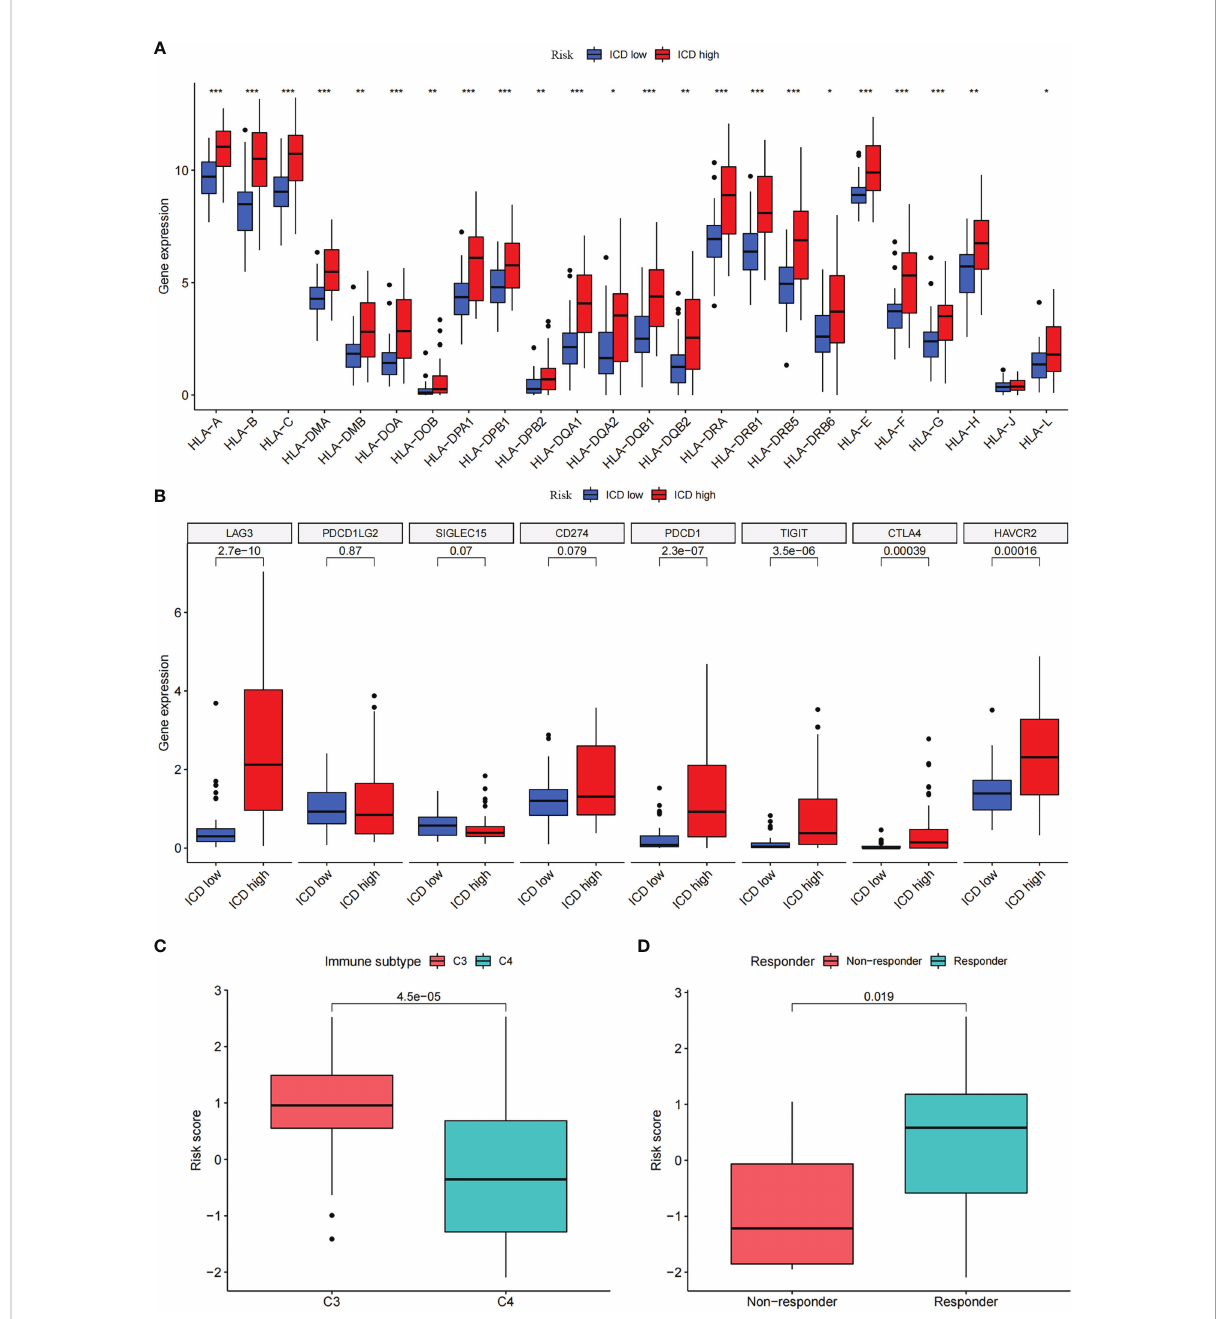
FIGURE 11 Differential expression of immune checkpoints and HLA genes. (A, B) Box plots of differential expressed immune checkpoints (B) and HLA genes (A) between the high and low ICD risk groups. (C) Box plots presents the association of ICD risk score with Immunotyping. (D) Box plot presents the links of ICD risk score with immunotherapy response. *P < 0.05, **P< 0.01, ***P <